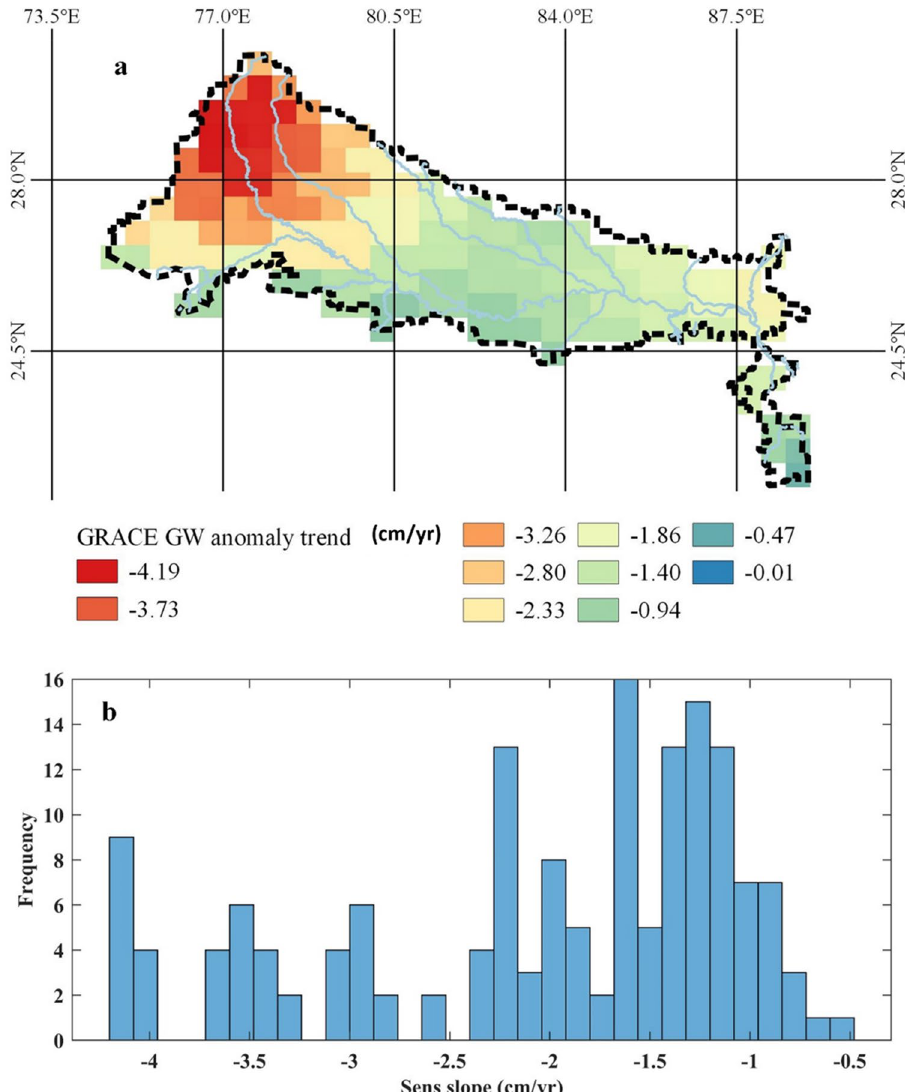
Figure 4. ( a ) GRACE groundwater storage anomaly trend (cm year −1 ). ( b ) Distribution of observed trends.